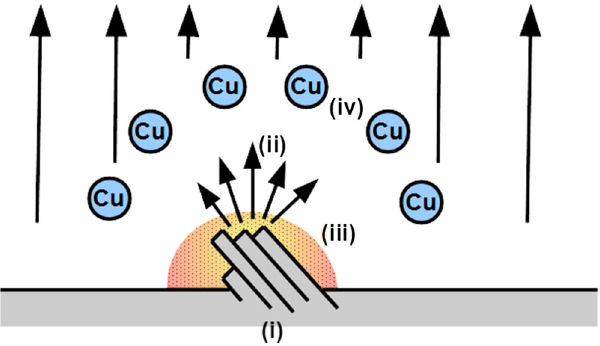
FIG. 1. Schematic description of the stages leading to arcing: (i) Extreme fields generate local stresses which, in turn, lead to dislocation activity, causing mobile dislocations to glide to the surface of the metal and modify it. (ii) The electric field and current on the surface are enhanced due to the surface mod- ifications. (iii) The enhanced current causes heating. (iv) Due to the heating, atoms are released from the cathode and plasma is formed, allowing current to arc between the